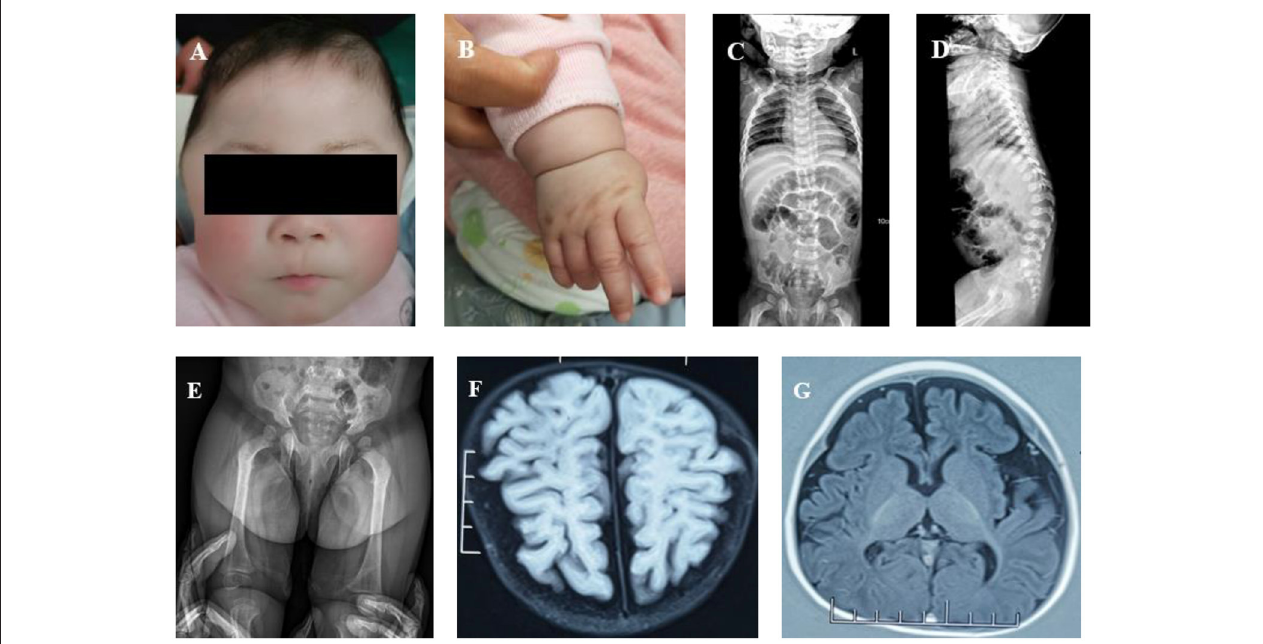
FIGURE 1 | (A) Abnormal facial features (a closed anterior fontanelle, prominent temporal parts, long eyelashes, sparse hair, upturned nostrils, a sharp beak-like mouth, low-set ears, a short neck, and white skin). (B) Wrist joint seam showing significant stenosis. (C) Spine X-ray: slight scoliosis of the spine and slightly narrow vertebral ends of ribs. (D) Spine X-ray: the spine showed slight kyphosis at the junction of the thoracolumbar segment, had short anterior and posterior diameters of some thoracolumbar vertebra, and there was anterior breakage of the vertebral body. (E) Spine X-ray: irregular acetabulum and lower edge of iliac bone. (F) Brain MRI: poor white matter development. (G) Brain MRI: smaller frontal lobe and thinner corpus